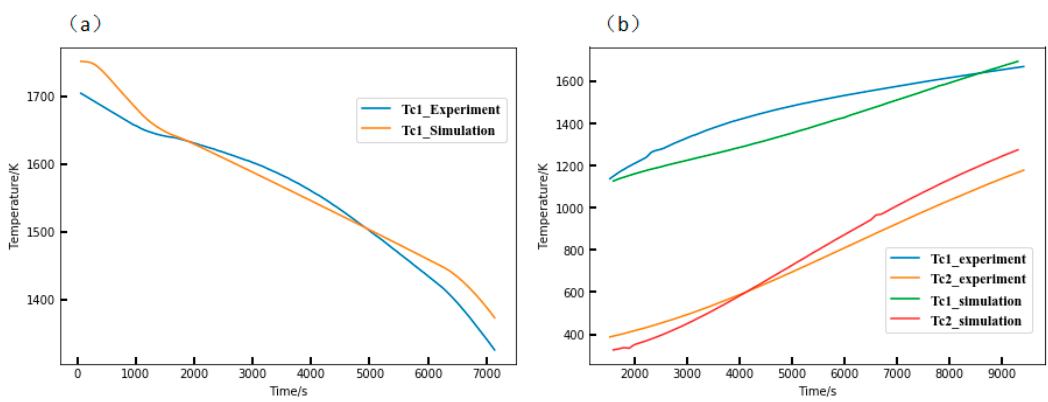
Figure 2. Measurement and simulation temperature. ( a ) In the furnace without crucible; ( b ) in the operation condition of the ingot growth process.